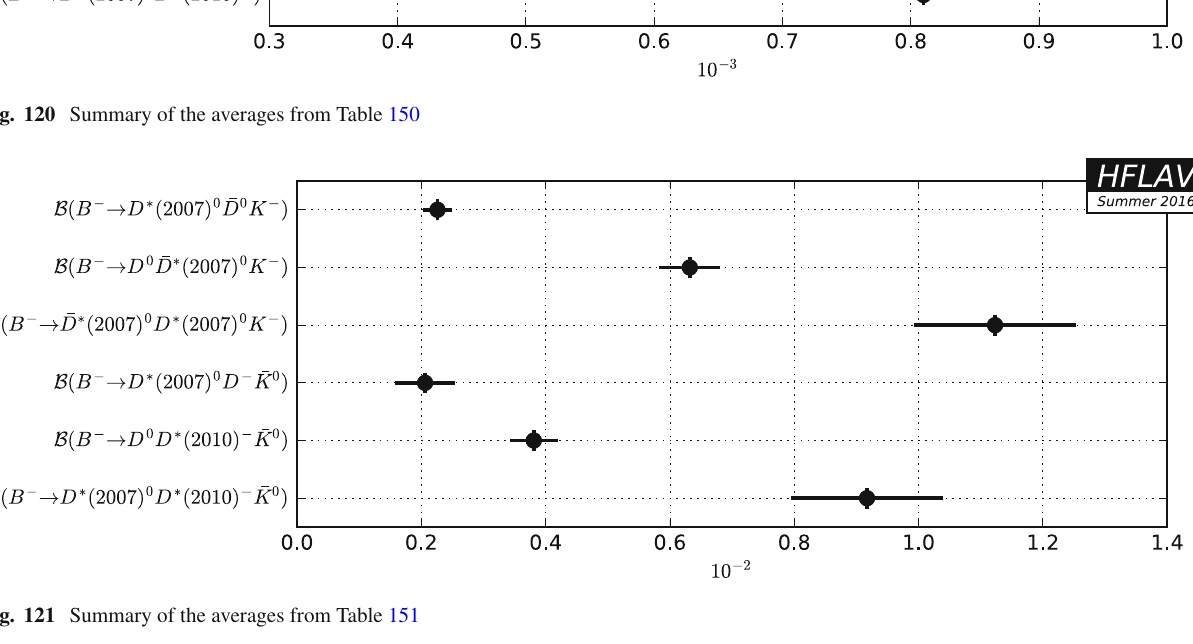
Fig. 121 Summary of the averages from Table 151